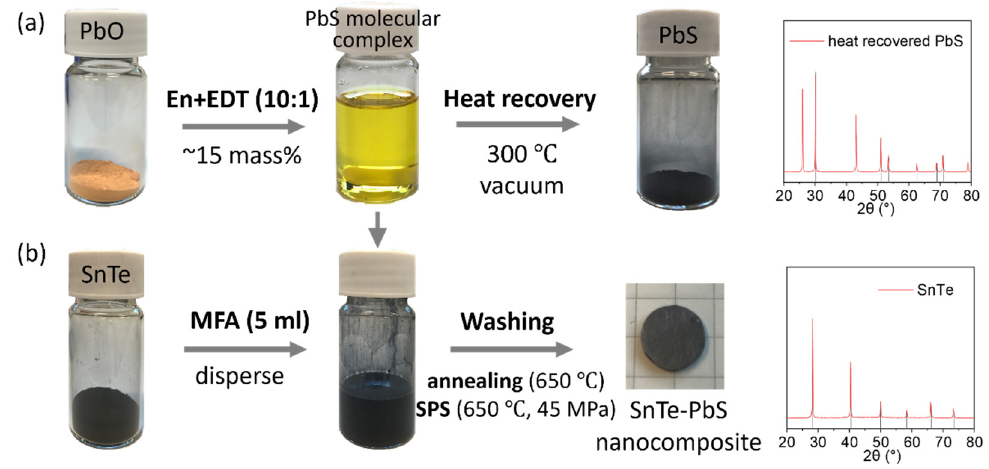
Figure 1. ( a ) The schematic of PbS molecular complex heat recovery and ( b ) SnTe-PbS nanocomposites assembly processing with the corresponding XRD pattern of heat recovered PbS and PbS surface-modified SnTe NPs.